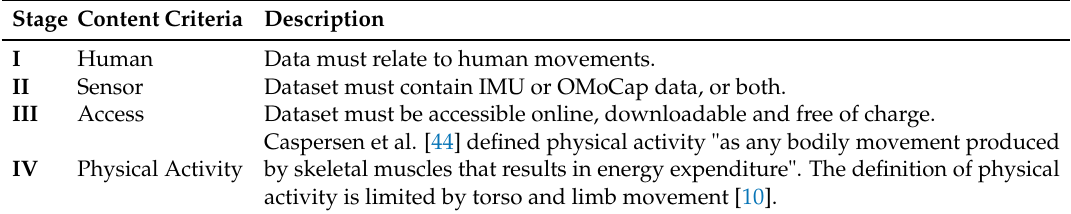
Table A1. Content criteria for filtering process.